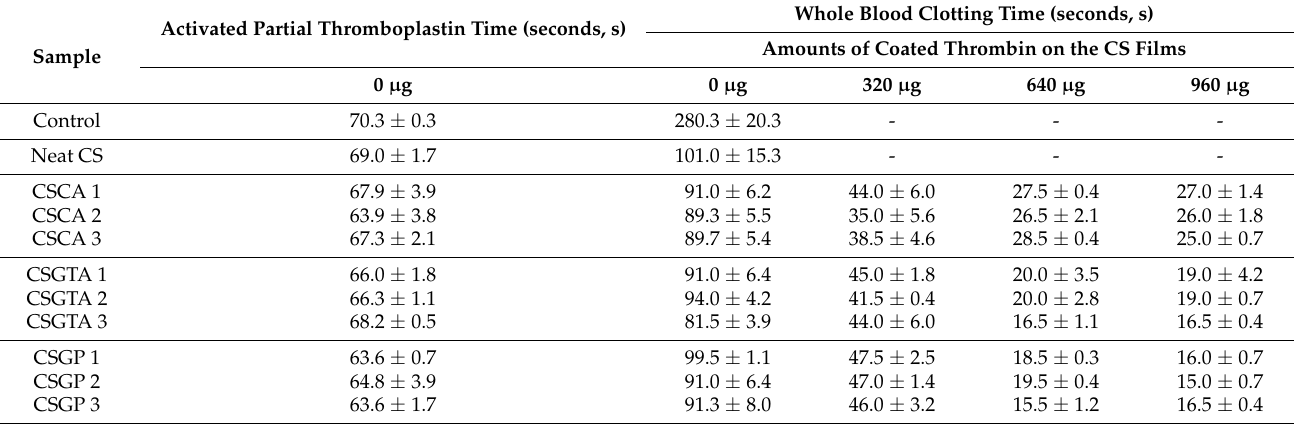
Table 4. Activated partial thromboplastin and whole blood clotting times of the crosslinked CS films and TB-CS films.